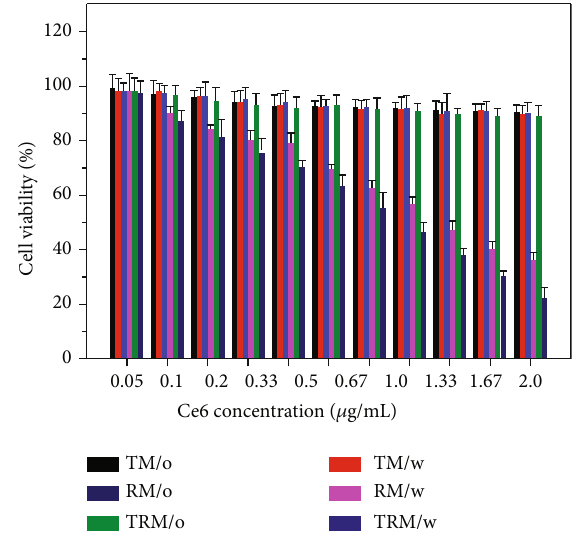
Figure 5: Dose-dependent cell viability of C6 cells with incubation of TM, RM and TRM under a 630 nm laser treatment for 5 min at 30 mW/cm 2 ( n = 3 ).